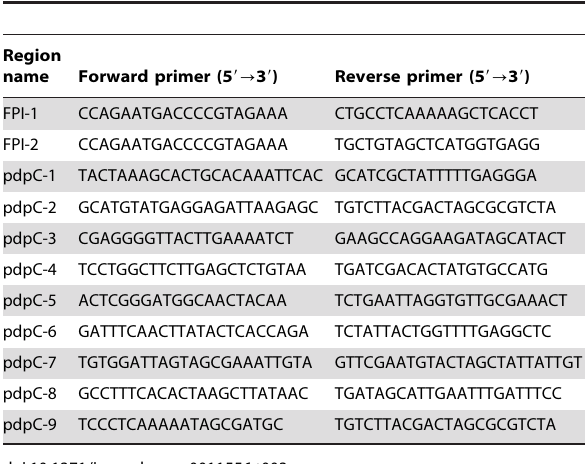
Table 3. Primers used to amplify regions surrounding pdpC1 and pdpC2 to confirm the Ftind52 and Ftind53